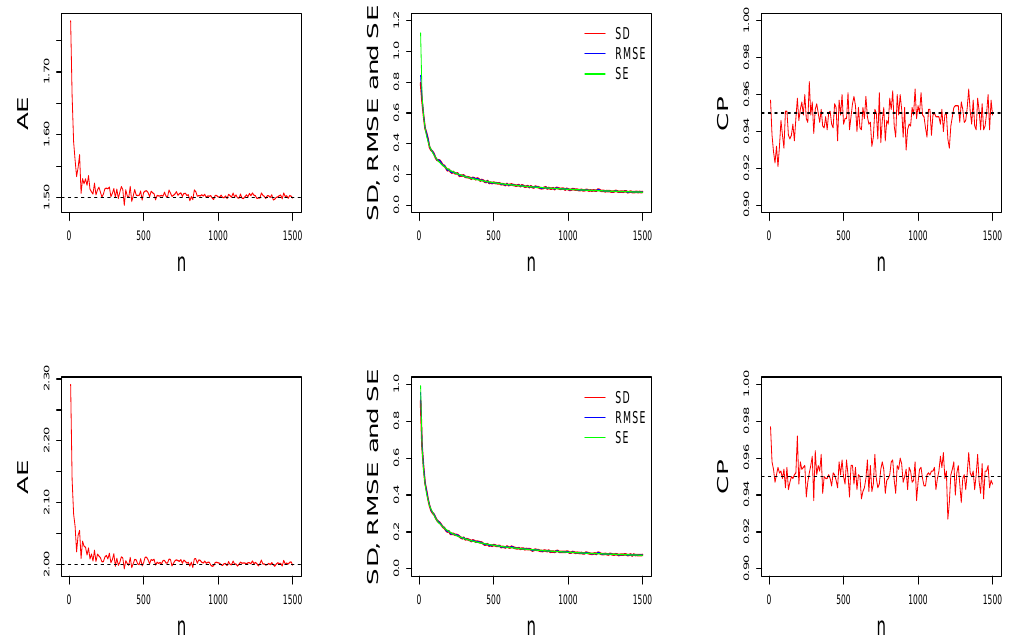
Figure 4. The AE, SD, RMSE, SE, and CP for each of the 1000 estimates of α ( top ) and β ( bottom ) obtained in scenario A, under the different sample